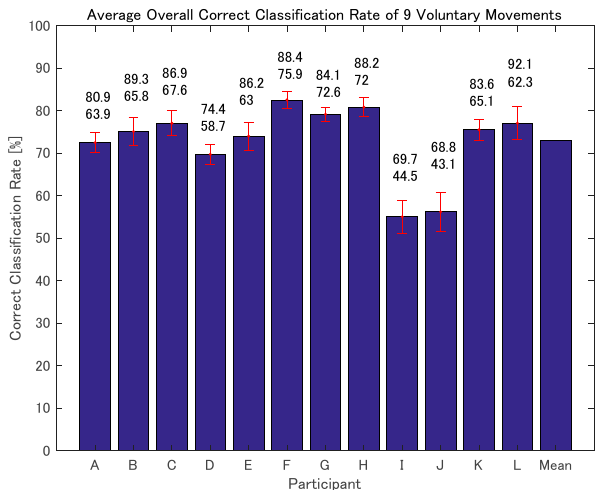
Figure 13. Average overall correct classification rate of 9 voluntary movements of 12 participants. The red error bars indicate standard deviation. The two numbers on top of the bars indicate highest and lowest overall correct rate. Note that the average correct rate of participant A, B, E and H are from the experiment on day 2 (best classification). Also, the mean overall correct rate indicates the overall correct rate across subjects.